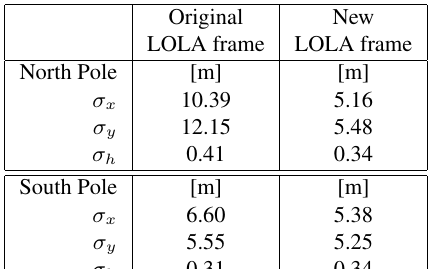
Original New LOLA frame LOLA frame